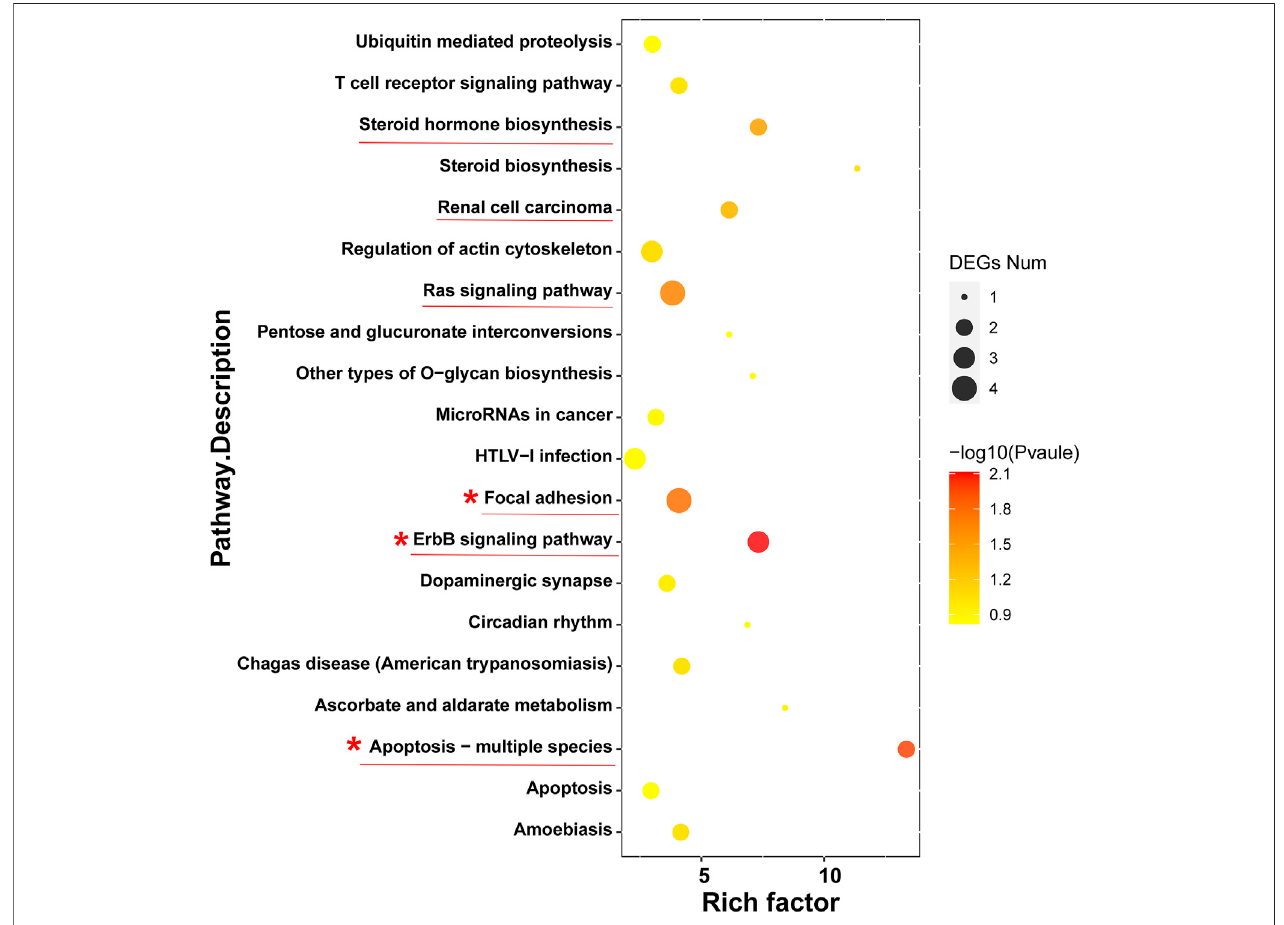
FIGURE 7 | “ Bubble diagram ” of the top 20 ranked DEGs using the KEGG